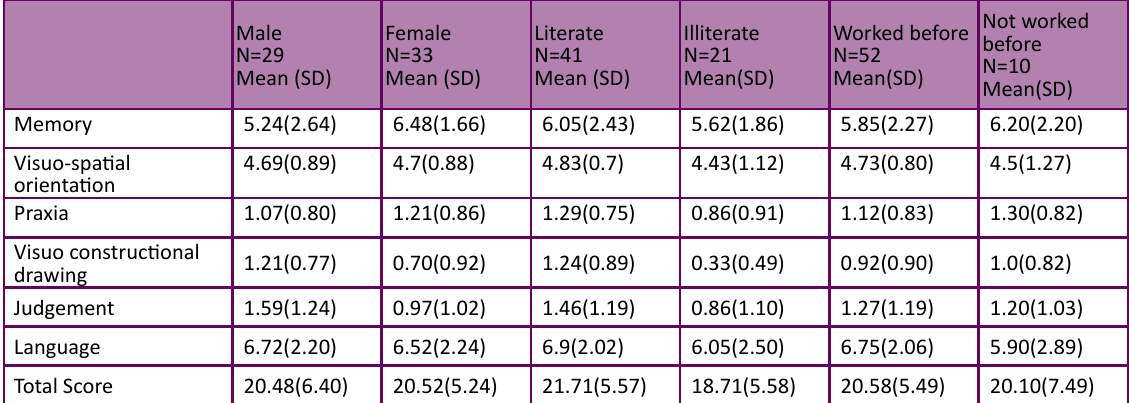
Table 2 – RUDAS total and subscores according to gender, literacy and